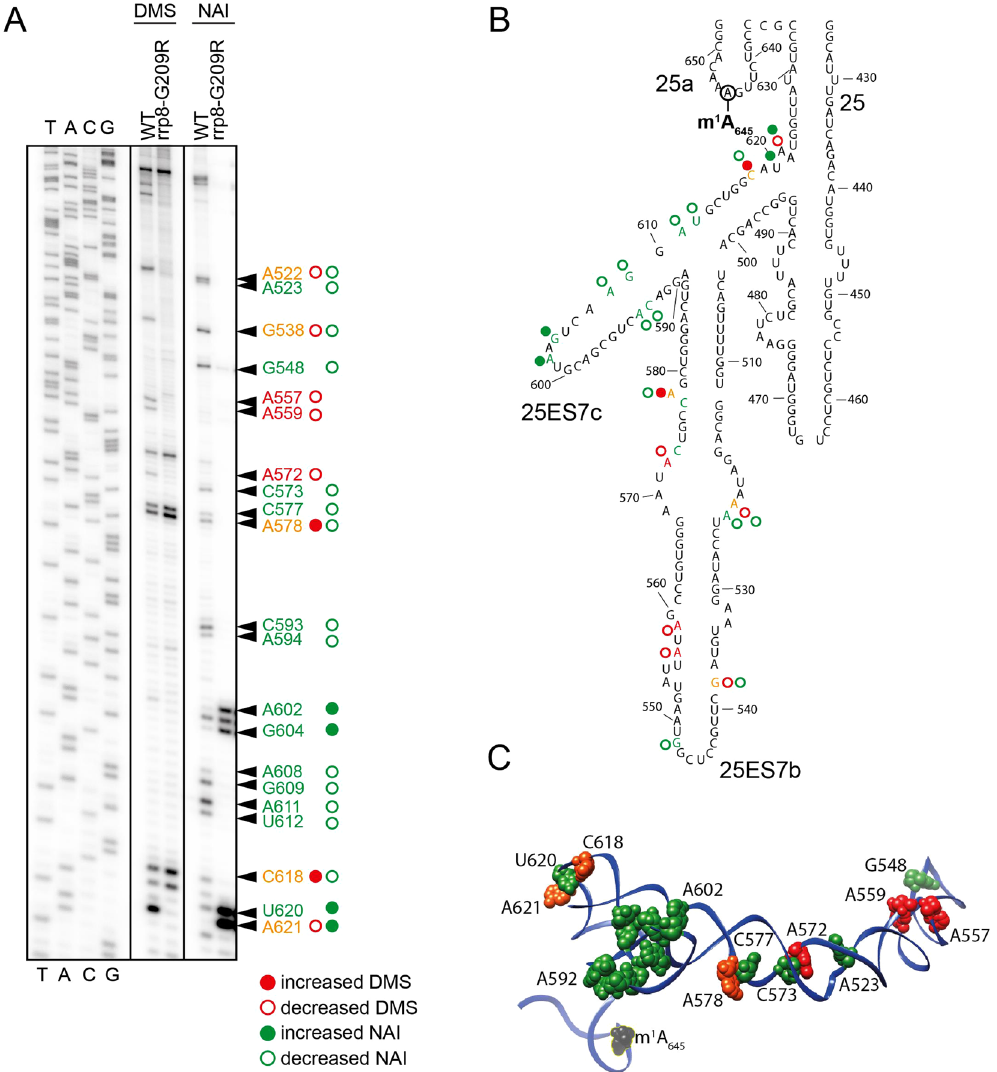
Figure 4. Loss of m 1 A 645 leads to structural changes within the LSU. ( A ) Representative gel showing structure probing with DMS or SHAPE analysis with NAI in the rrp8 G209R loss of methylation mutant. 32 P-labeled primer (helix25_StrPrb) complementary to nucleotides 2428 to 2448 of human 28S rRNA were used for the analysis. Bands corresponding to modified residues are marked in red for DMS, green for NAI and orange for both. ( B ) 2-D structure model with mapped modified residues as described in ( A ). ( C ) The residues sensitive to chemical modification are represented as spheres on a 3-D structure model of helix 25 (color scheme as in panel A). The model was made using Chimera and PDB file